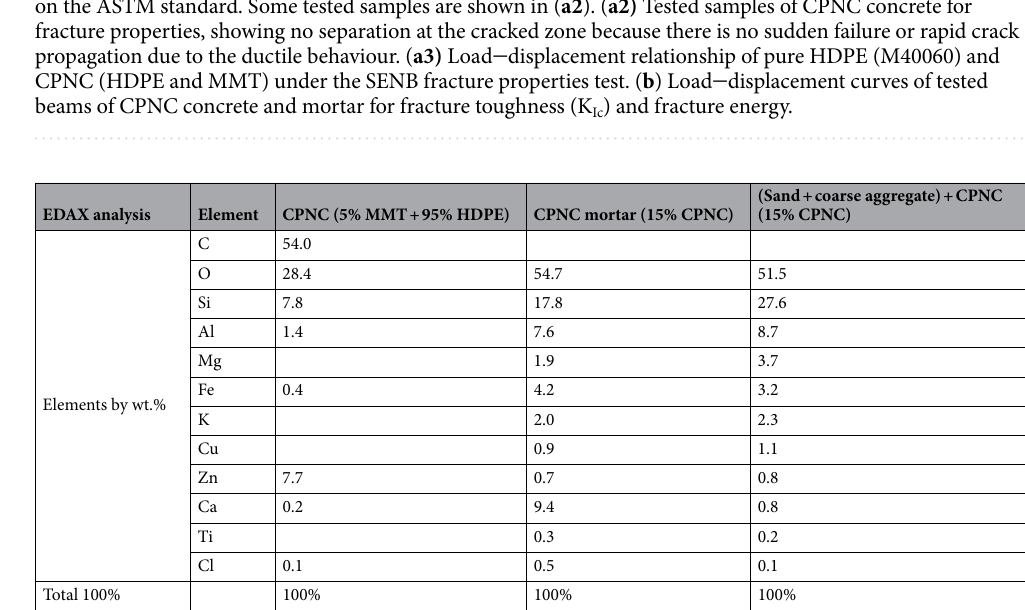
Table 5. EDAX chemical compositions of CPNC, CPNC mortar, and CPNC